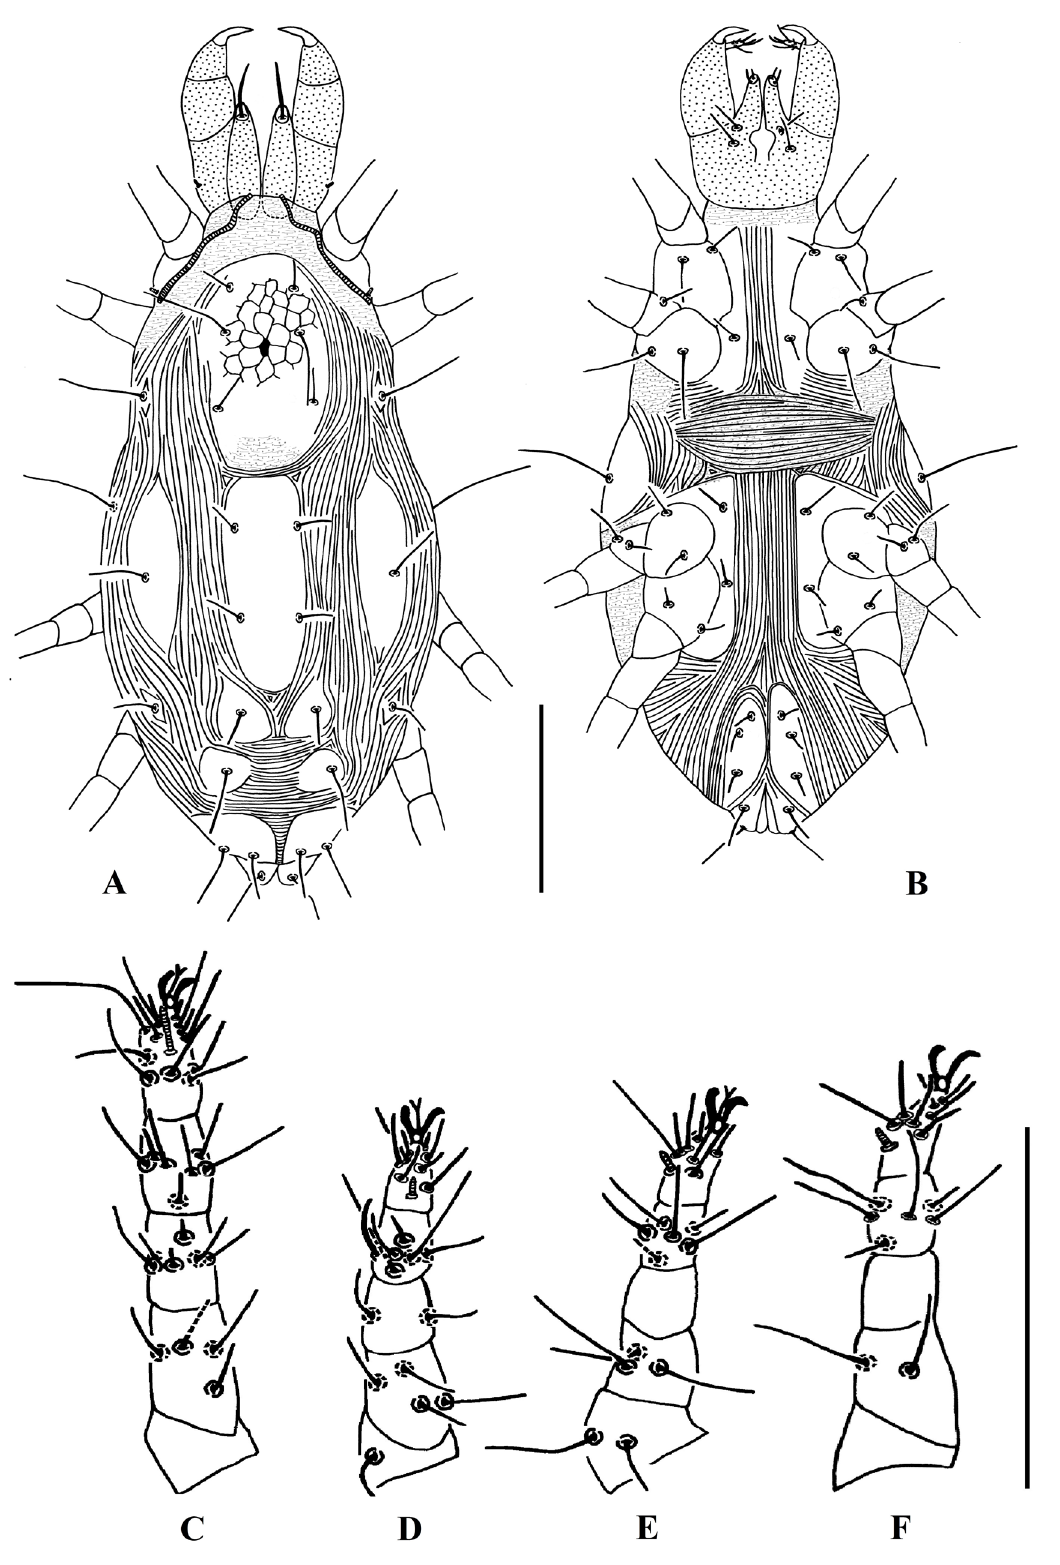
Fig. 4. Stigmaeus miandoabiensis Bagheri & Zarei, 2012 (deutonymph). A . Dorsum of body. B . Venter of body. C . Leg I. D . Leg II. E . Leg III. F . Leg IV. Scale bars = 100